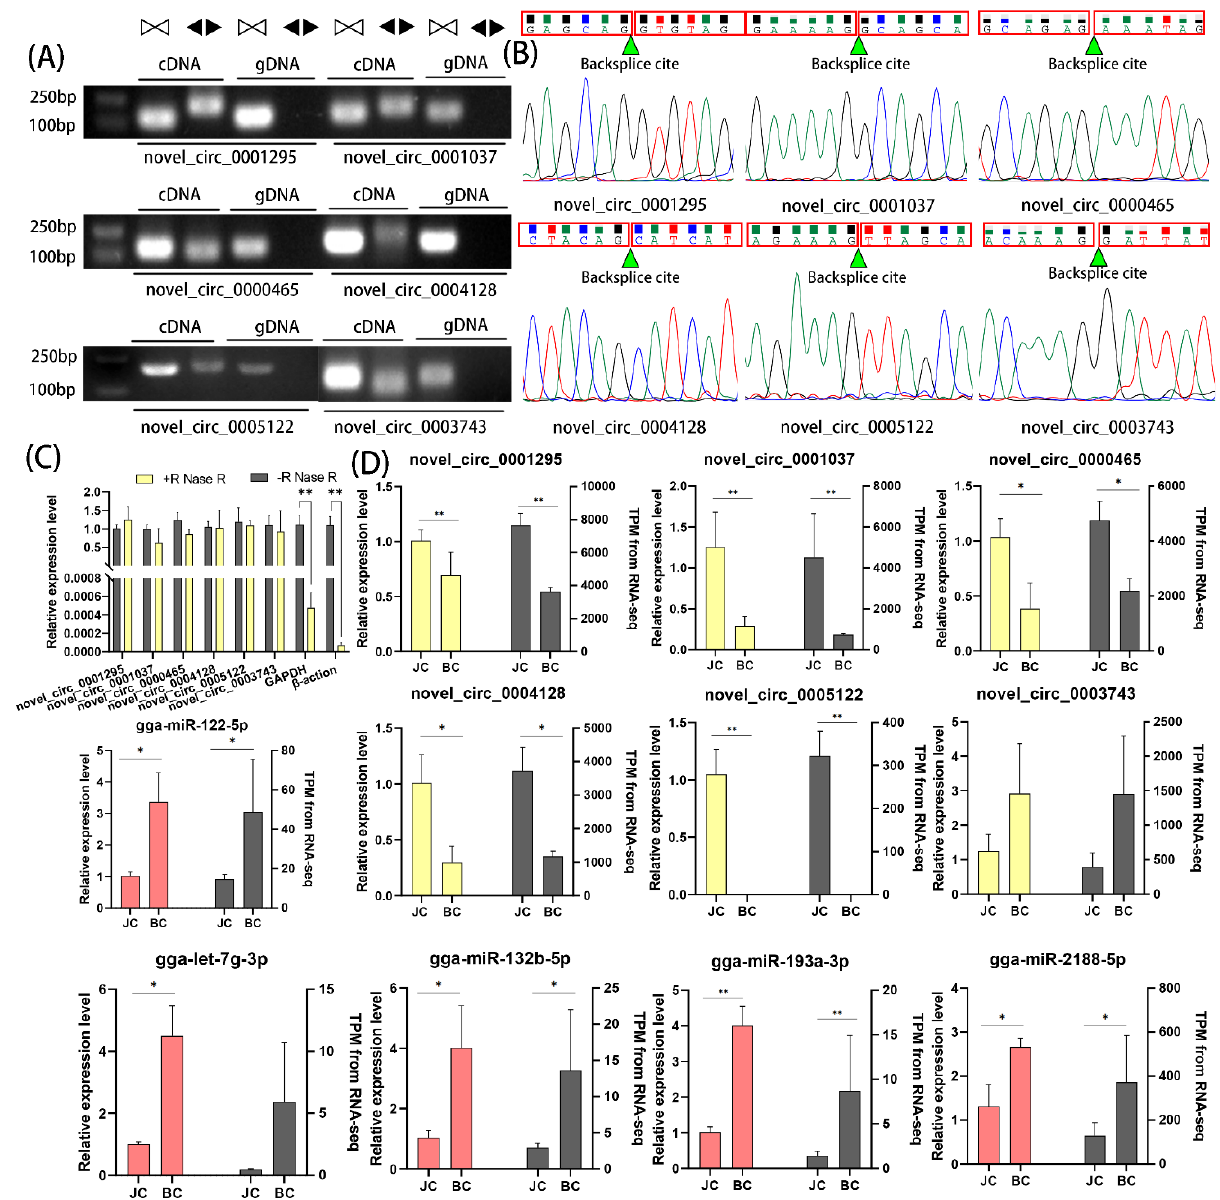
Figure 6. RT-qPCR validation of DEcircRNAs and DEmiRNAs: ( A ) Divergent primers amplified circRNAs in cDNA but not genomic DNA (gDNA). White triangles represent convergent primers and black triangles represent divergent primers; ( B ) Sanger sequencing confirmed the back-splicing junction sequence of circRNAs; ( C ) RT-qPCR showed resistance of circRNAs to RNaseR digestion. (D) RT-qPCR validation of six DEcircRNAs and five DEmiRNAs. Data were expressed as mean ± SEM. ** P < 0.01, * P < 0.05.